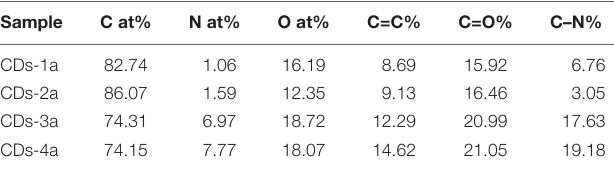
TABLE 3 | The elements content and functional groups of different CDs